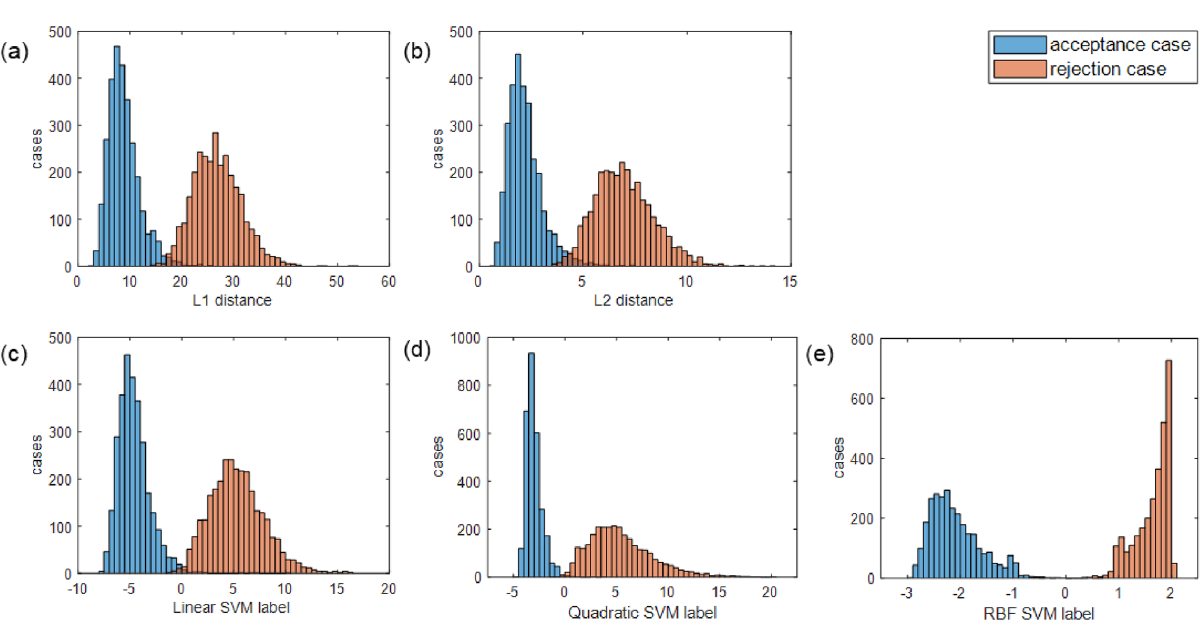
Figure 5. Distribution of classifier outputs, from acceptance case and rejection case pairs. The acceptance cases are displayed as blue histogram, while rejection cases are displayed as red histogram. Each of five figures corresponds to L1 norm calculation, L2 norm calculation, and SVMs with three kernels. The horizontal axis represents the output values from the